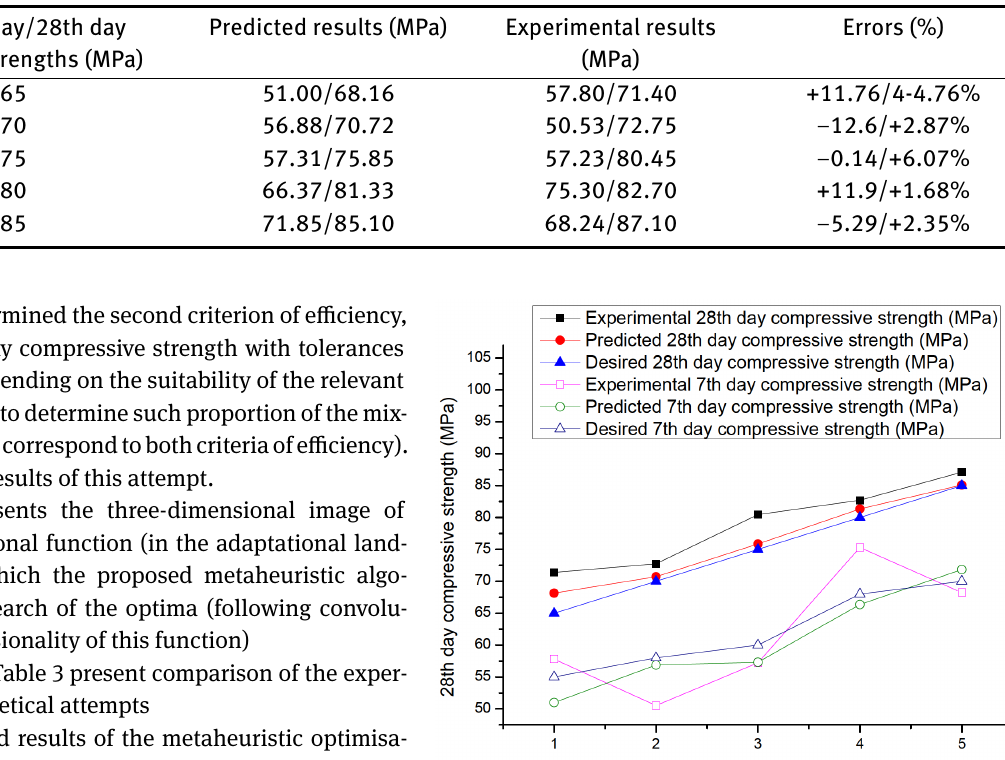
Table 3: Comparison of the predicted and experimental results.